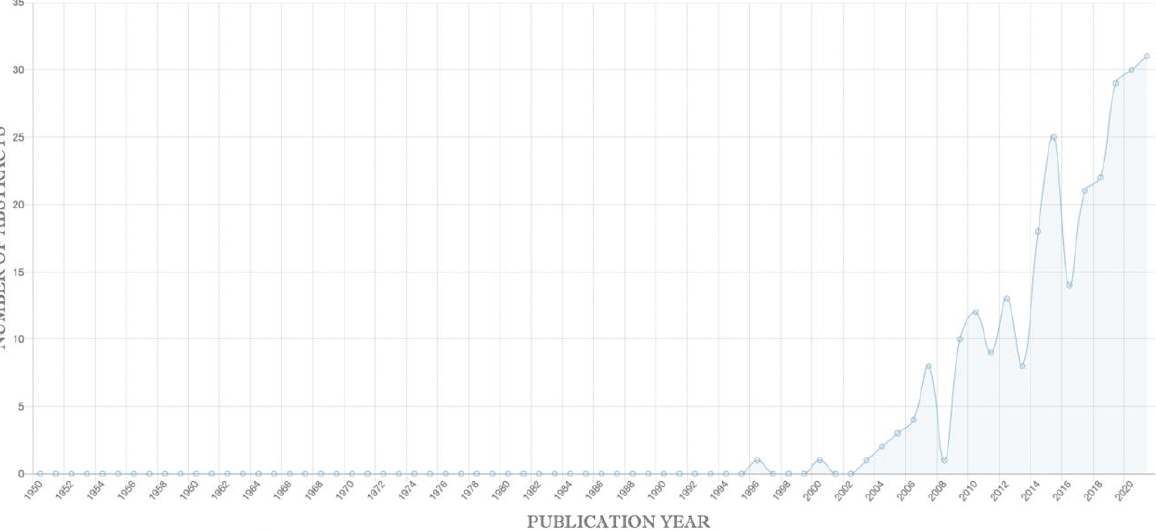
Figure 6. Graph showing the growth in PubMed abstracts mentioning the sigma-1 receptor by year generated with ANDDigest ver. 01.2022.